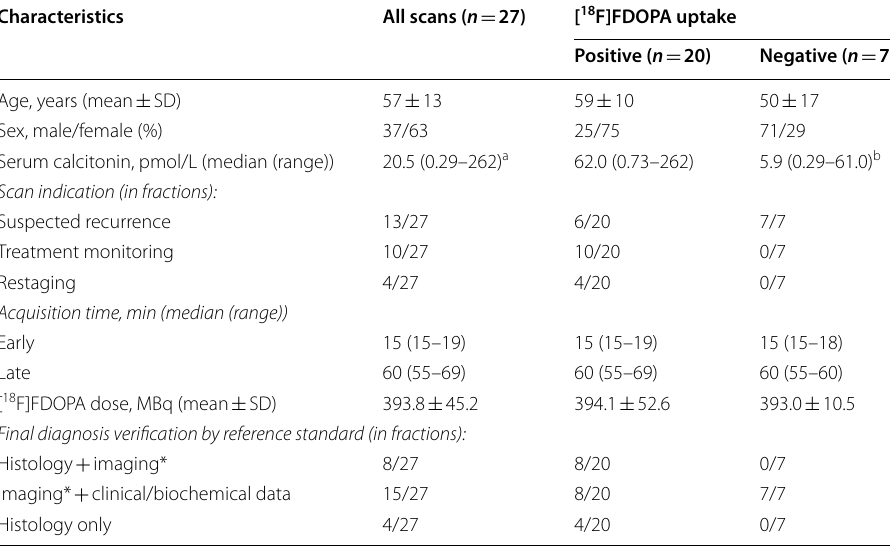
Table 1 Clinical characteristics of the study